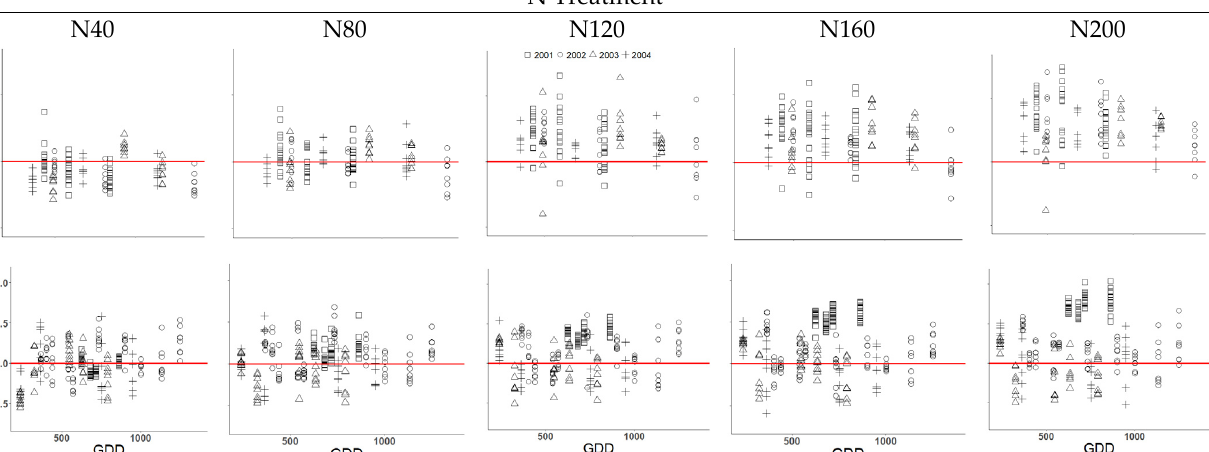
Figure 3. Boxplot showing the mean and the standard deviation for N up , N a and DM measurements for 2001, 2002, 2003, 2004 per GDD for each N treatment.